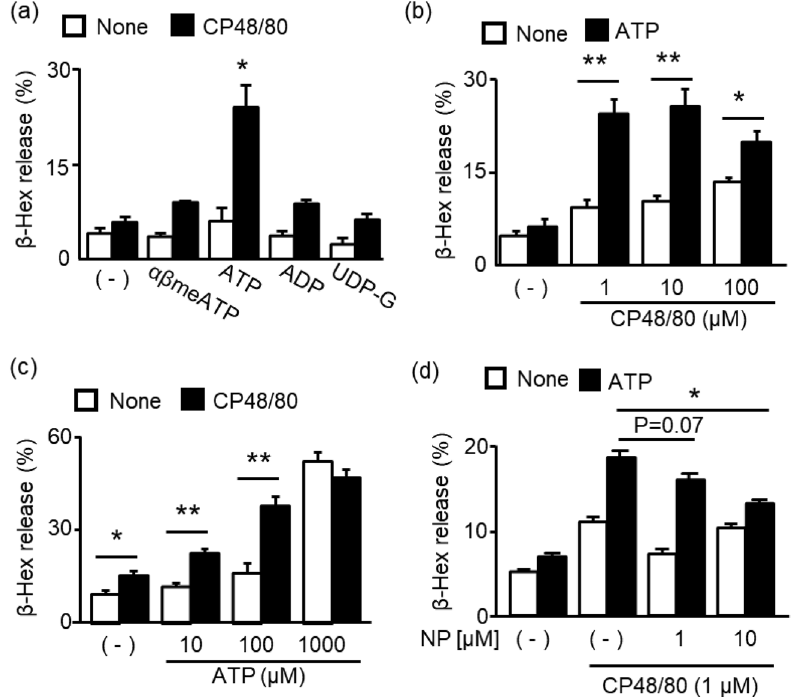
Figure 1. Effects of purinergic receptor agonists on CP48/80-induced degranulation in PMCs. ( a ) PMCs were stimulated with αβmeATP (10 μM), ATP (100 μM), ADP (100 μM), or UDP-G (100 μM) in the presence or absence of CP48/80 (1 μM) for 10 min. ( b ) PMCs were stimulated with CP48/80 (1–100 μM) in the presence or absence of ATP (100 μM) for 10 min. ( c ) PMCs were stimulated with ATP (10–1000 μM) in the presence or absence of CP48/80 (1 μM). ( d ) PMCs were stimulated with ATP (100 μM) and CP48/80 (1 μM) in the presence or absence of P2X4R antagonist NP-1815-PX (NP, 1 or 10 μM). Data are presented as the mean ± SEM (n = 3). *P < 0.05, **P <